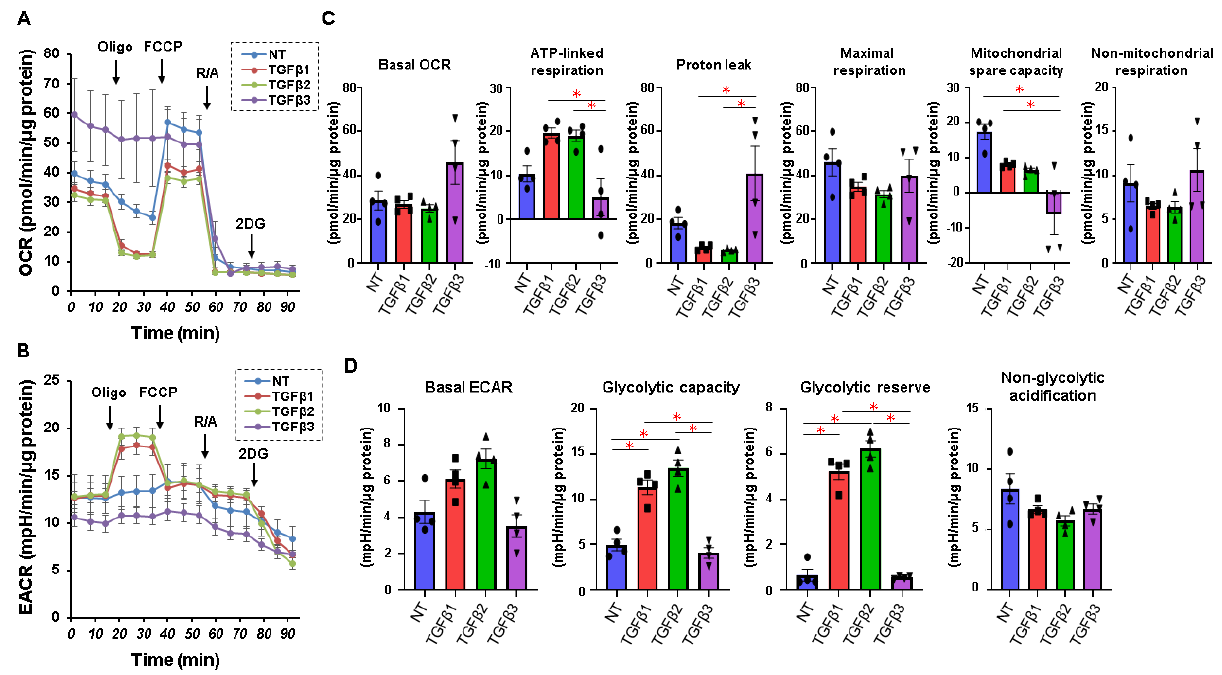
Figure 1. Effects of TGF ‐β isoforms on the barrier functions of 2D cultures of HTM cell monolayers by trans ‐ endothelial electrical resistance (TEER) ( A ) and FITC ‐ dextran permeability measurements ( B ). In the presence or absence of 1, 5, or 10 ng/mL TGF ‐β‐ 1, TGF ‐β‐ 2, or TGF ‐β‐ 3, the 2D cultured HTM monolayers were subjected to TEER and FITC permeability measurements. Plots of the TEER values ( Ω cm 2 ) are shown in panel A, and the fluorescein intensities at an excitation wavelength of 490 and an emission wavelength of 530 nm are plotted in panel B. The numbers of cells within the 100 μ m × 100 μ L squares (n= 10 different area) in the TEER 2D planar culture plate (NT; 4.2 ± 1.17, TGF ‐β‐ 1; 4.4 ± 1.85, TGF ‐β‐ 2; 5.0 ± 1.53, TGF ‐β‐ 3; 4.6 ± 0.93). All experiments were performed in triplicate using fresh preparations (n = 4). *** p < 0.005.